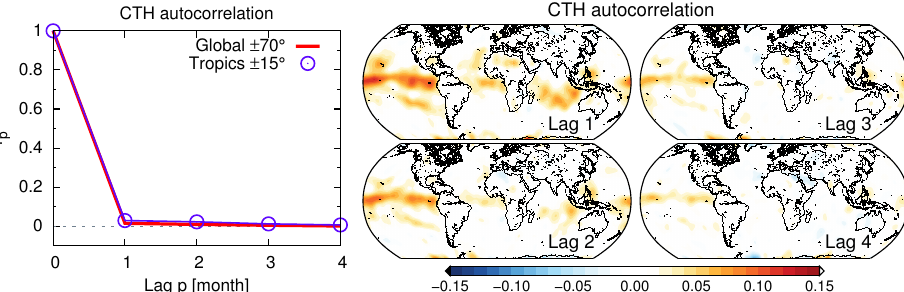
Figure 4. (Left plot) Autocorrelation function of CTH anomalies. Unlagged data ( p = 0) correlate perfectly with themselves ( r 0 = 1). r p Fig. 4. (Left plot) Autocorrelation function of cloud top height anomalies. Unlagged data ( p = 0) correlate decays to almost 0 already at p = 1. (Right plot) Maps of CTH autocorrelation for the first 4 months. ENSO-related patterns are seen over 6.2 Cloud top height timeseries perfectly with themselves ( r 0 = 1). r p decays to almost 0 already at p = 1. (Right plot) Maps of CTH autocor- the Pacific, Indian and Atlantic Oceans. relation for the first 4 months. ENSO-related patterns are seen over Pacific, Indian and Atlantic Oceans.